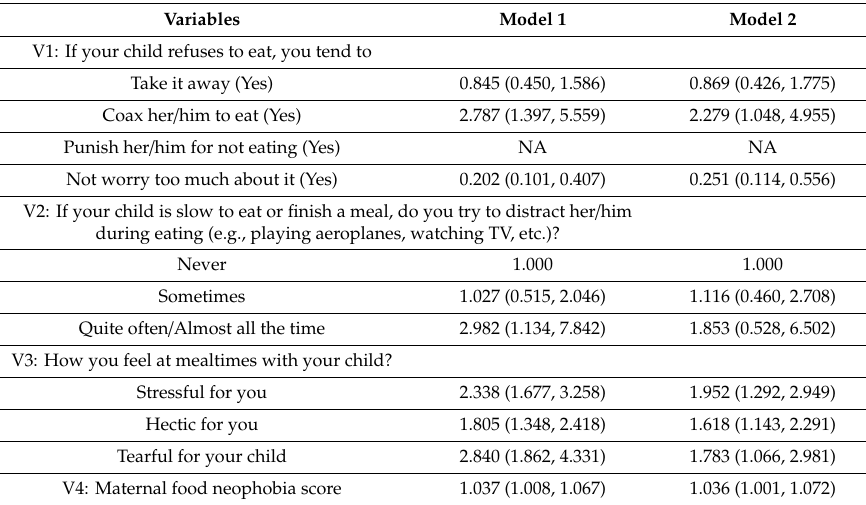
Table 4. Associations between maternal feeding factors and child’s high food neophobia score with controlling covariates. Variables Model 1 Model